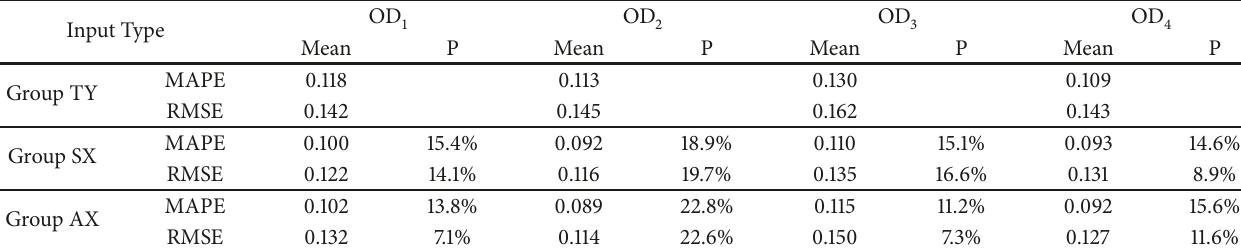
Table 3: Prediction result using BPNN model for different input data.